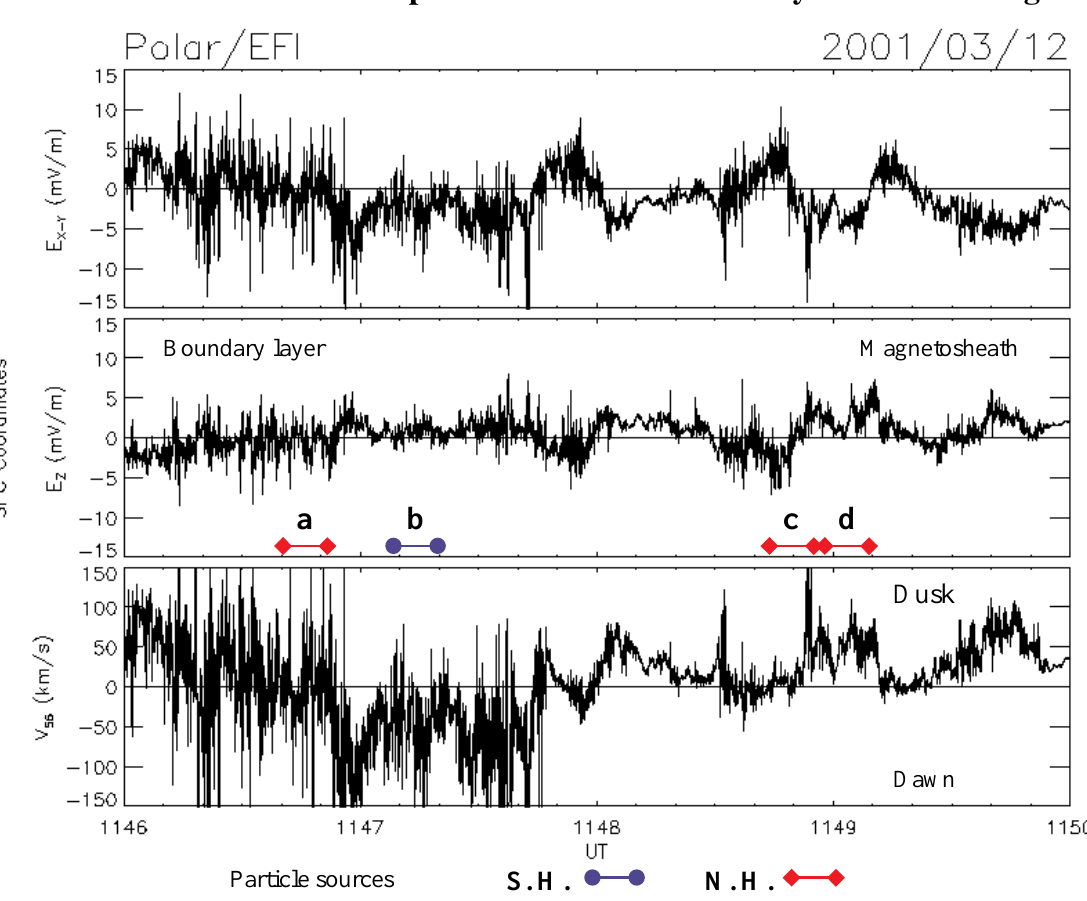
Fig. 3. High resolution (40Hz) measurements of the 2 components of the electric field in the spin plane and the resulting drift velocity along the spin axis, which is roughly in the Y direction (toward dusk). The letters refer to panels in Fig. 8 of Maynard et al. (2003). The circular dumbells represent intervals when fluxes are coming from below the satellite, while the diamond dumbells represent times when ions are coming from a Northern Hemisphere source above the